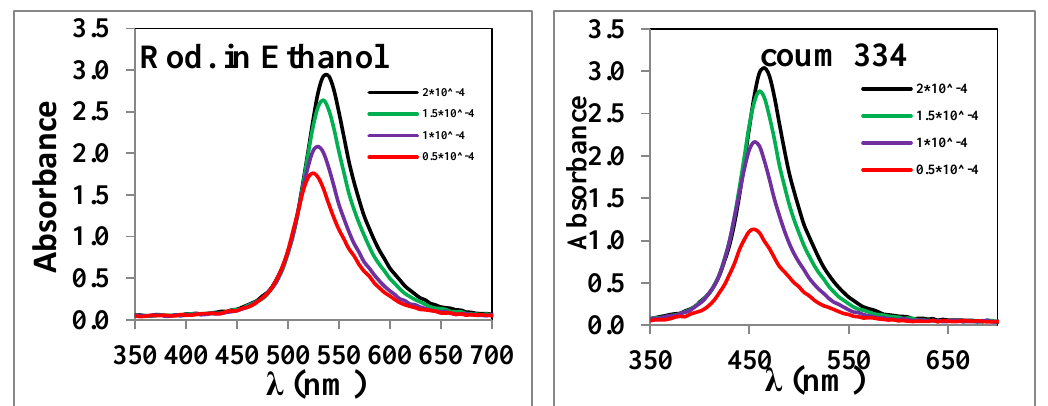
Fig. 4: The absorption spectrum of (a) Coumarin 334 and (b) Rhodamine 590 dye solution.